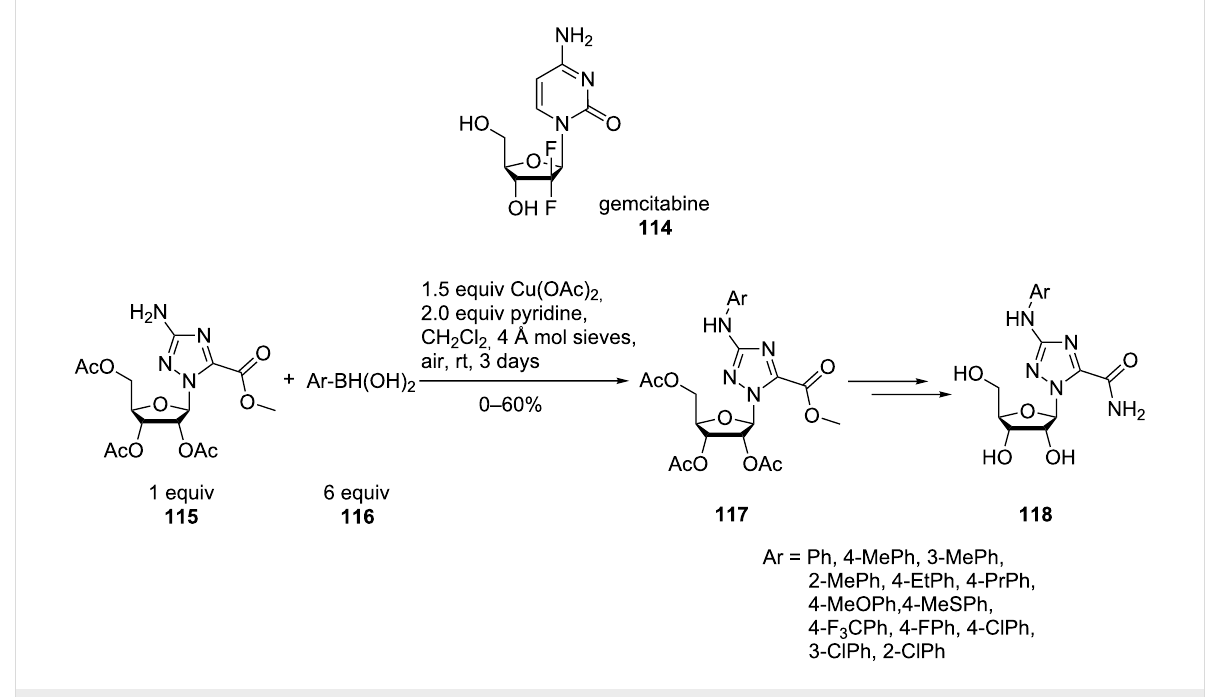
Scheme 27: N -Aryltriazole ribonucleosides with anti-proliferative activity.